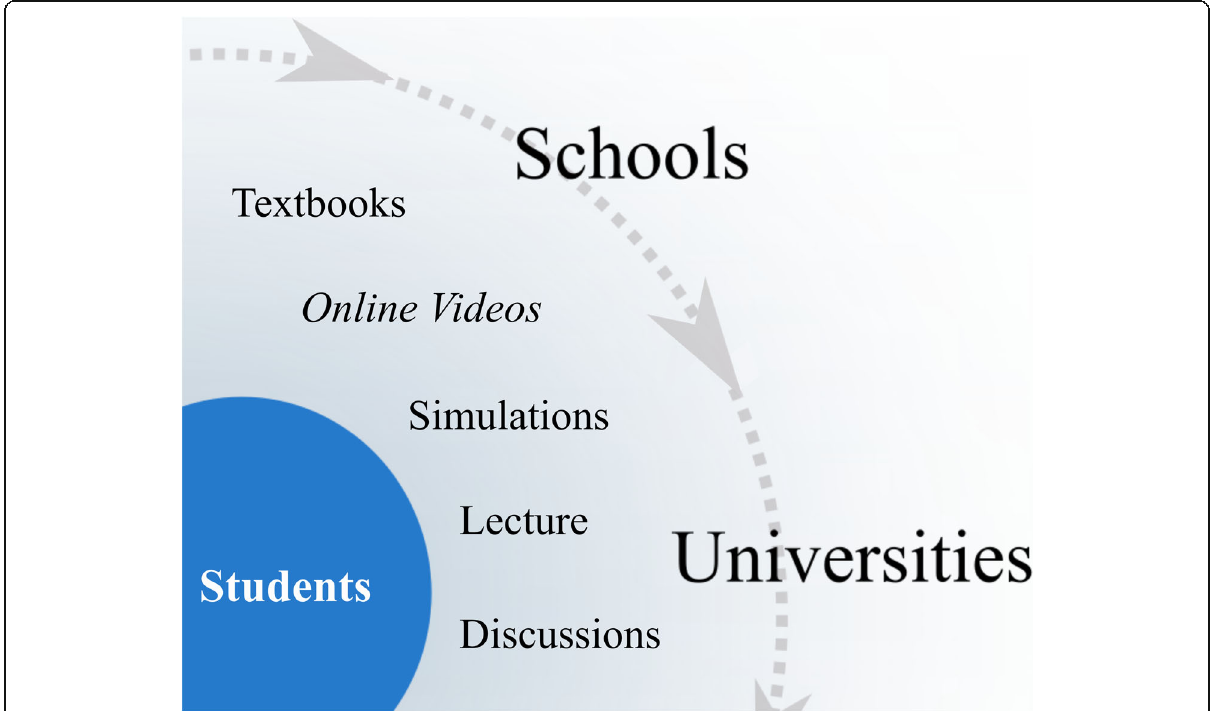
Fig. 1 Example of the parts of learning ecosystem explored in this